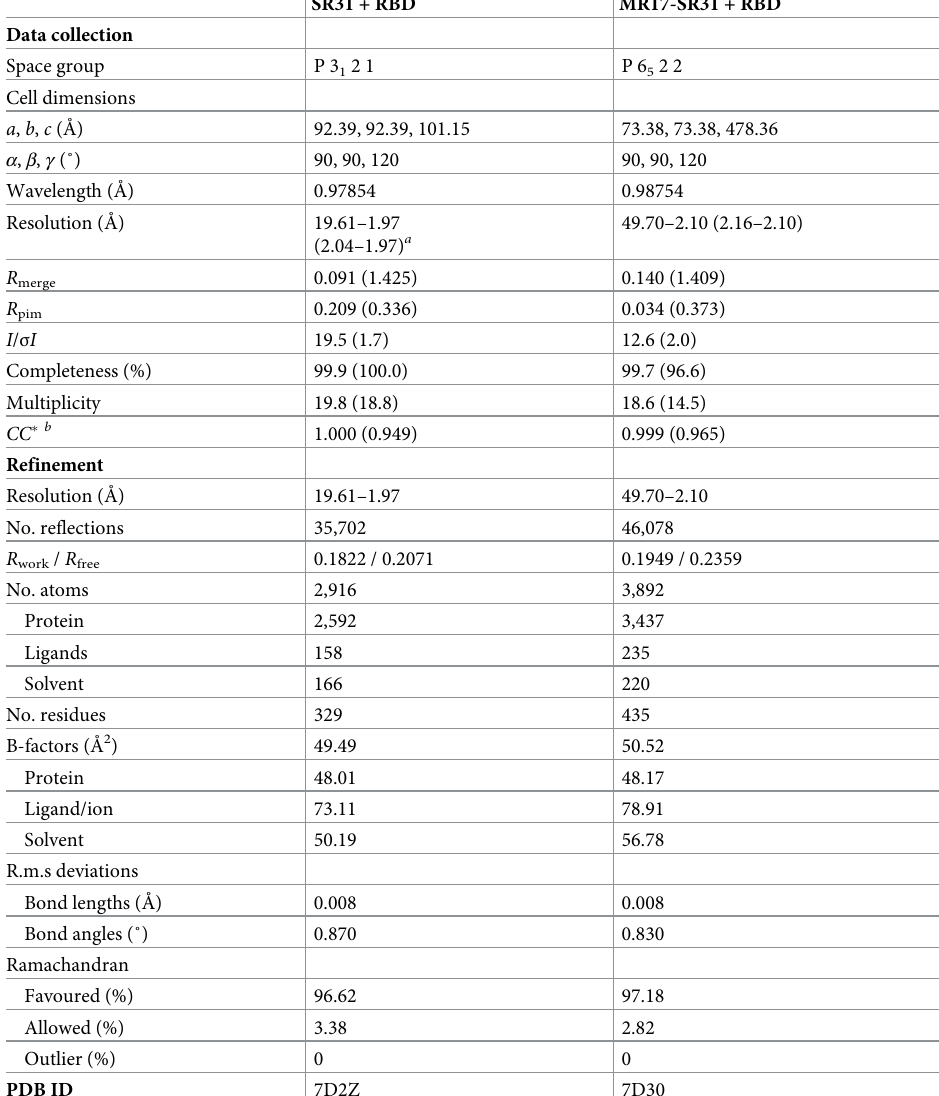
Table 1. Data collection and refinement